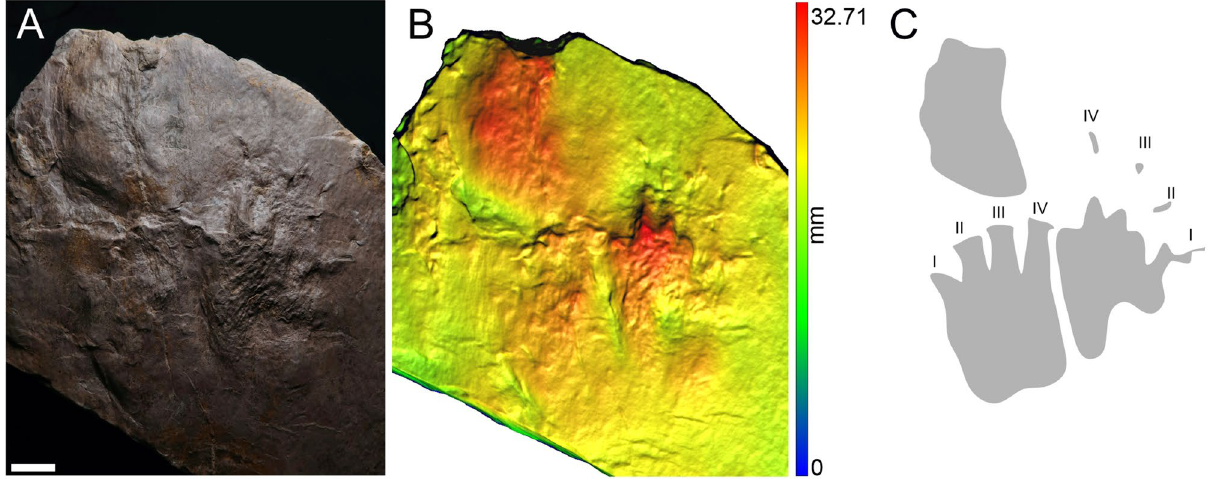
Figure 5. Three isolated tracks of MZM Ge 33073 (convex hyporelief) ( A ), image ‐ based modeling ( B ), and the outline drawing ( C ). Scale bar 4